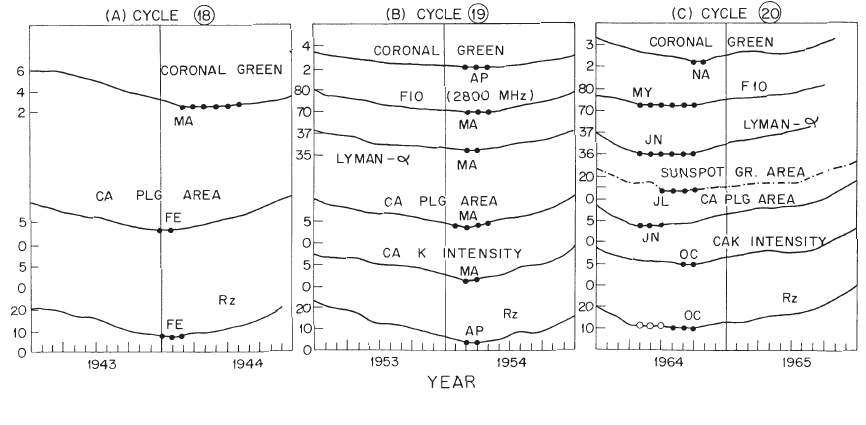
Fig. 9. Plots of the 12-month mov- ing averages of various indices during years of sunspot minima of (A)